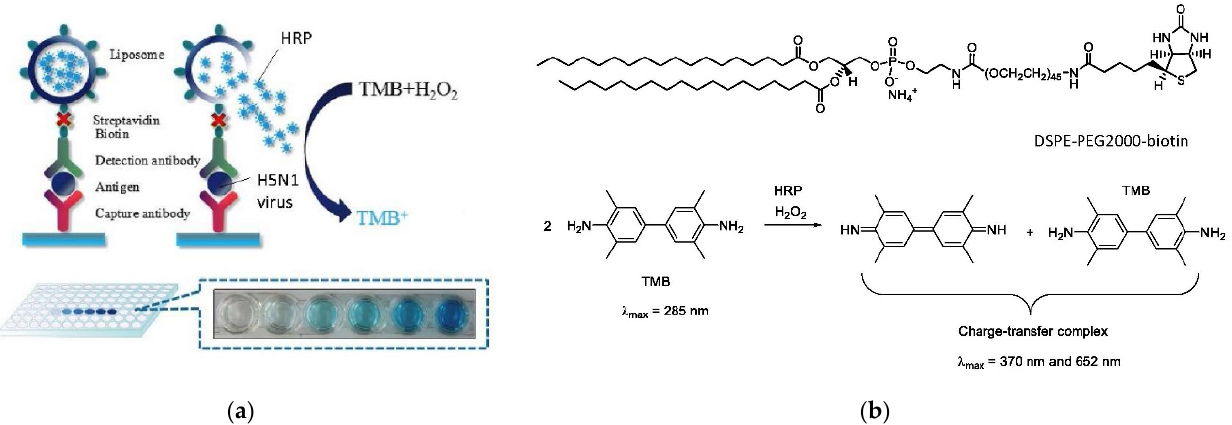
Figure 34. Application of enzyme-containing lipid vesicles in an immunoassay for the quantitative determination of influenza virus H5N1, as published by Lin et al. (2017) [480]. ( a ) Illustration of the concept of the method. A capture antibody is adsorbed onto the solid surface of a 96-well microplate. The antigens present in the analyte medium—H5N1 virus particles—bind selectively to the surface-bound capture antibody. Addition of a biotinylated detection antibody results in binding of the biotinylated capture antibody to the antigen. Following addition of streptavidin, added biotinylated lipid vesicles containing entrapped horseradish peroxidase (HRP) bind to streptavidin. After washing, quantification of HRP is achieved by using 3,3 ′ ,5,5 ′ -tetramethylbenzidine (TMB) and hydrogen peroxide (H 2 O 2 ) as substrates at pH ~ 4–5, whereby HRP may leak from the vesicles. ( b ) The one-electron oxidation of two TMB molecules—followed by a disproportionation reaction—yields a blue colored charge-transfer complex between the diimine product and TMB, with λ max ~ 650 nm; see [481]. The liposomes were prepared from egg PC, cholesterol and DSPE-PEG2000-biotin; see [480] for details. Reproduced with permission from [480], Elsevier, 2017.